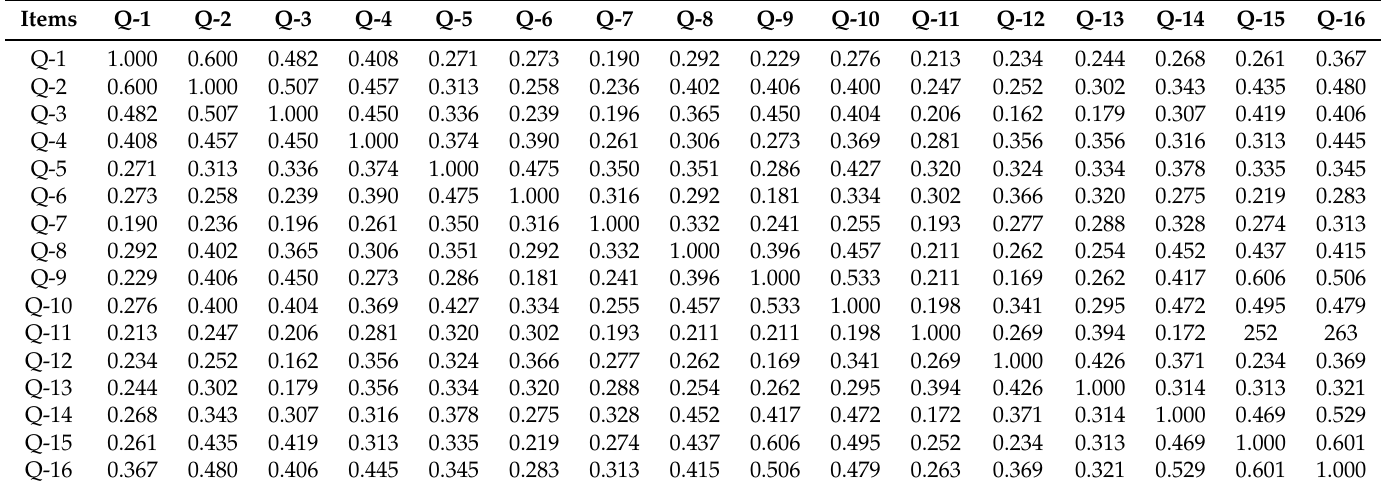
Table 7. Correlation matrix for the 16 items in the